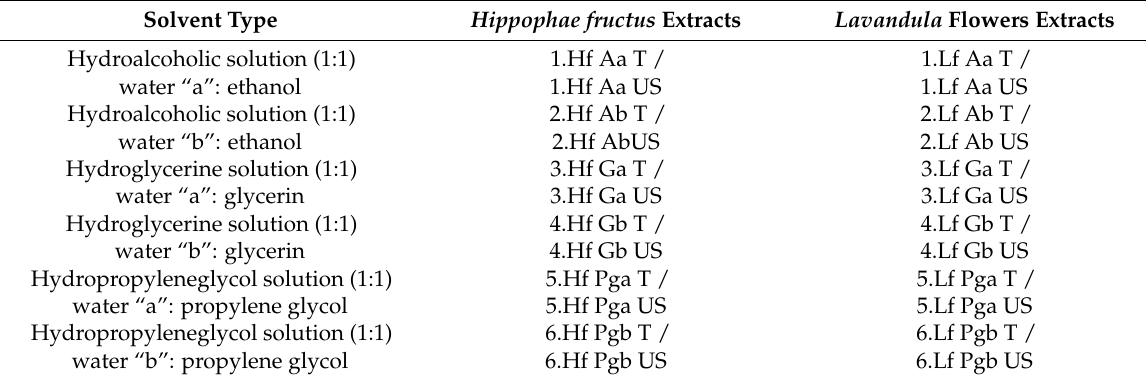
Table 1. List of used plant extracts with corresponding extraction solvent and extraction